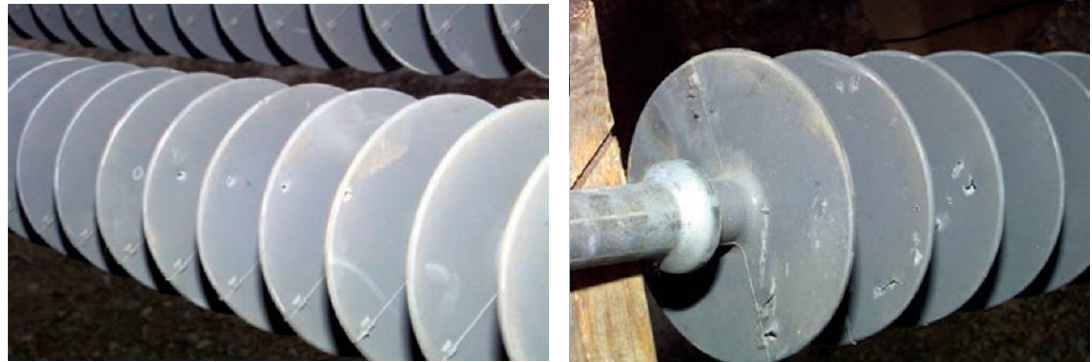
Figure 8. Example images of polymer insulators having bullet shot defect [45]. When hit by bullet shots, polymer insulators do not shatter like ceramic insulators because polymer is not brittle.